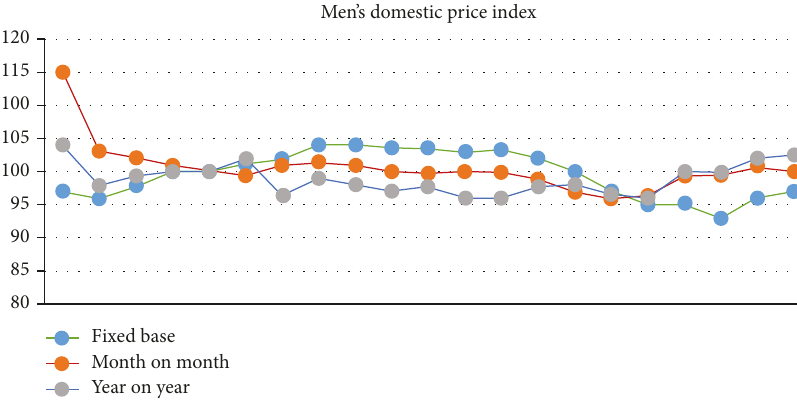
Figure 8: China Changshu men’s wear